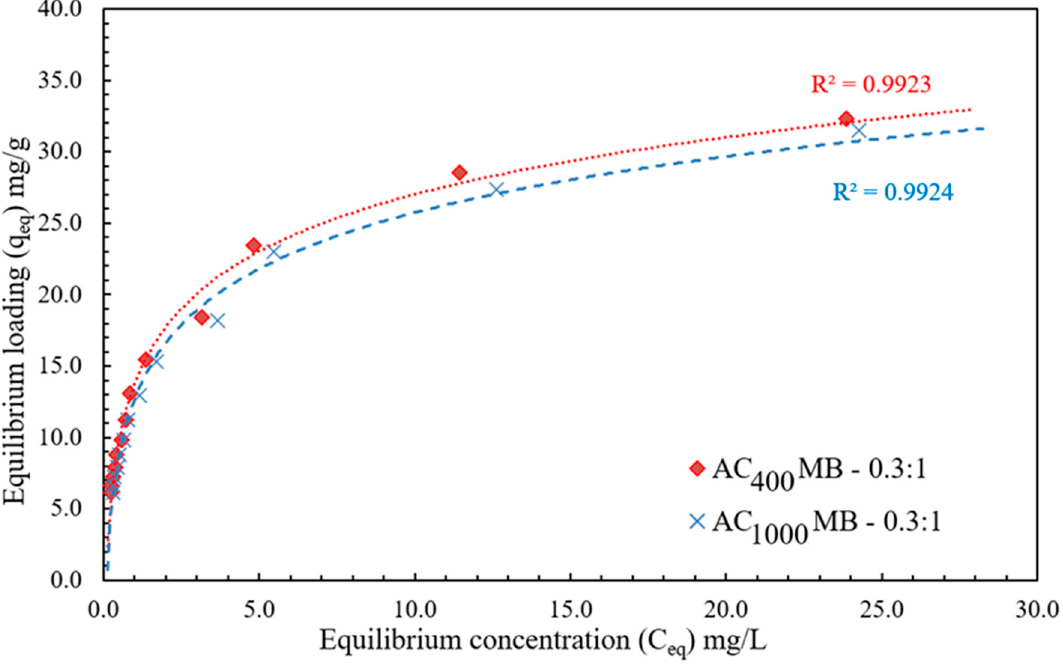
Figure 15. The adsorption isotherm for DB78 dye removal using AC 400°C MB-0.3:1 and AC 1000°C MB-0.3:1.